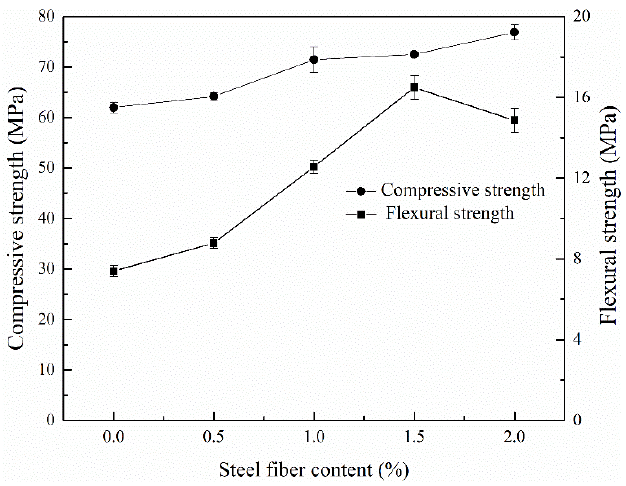
Figure 3. Compressive strength and flexural strength of HMGC with different steel fiber contents.